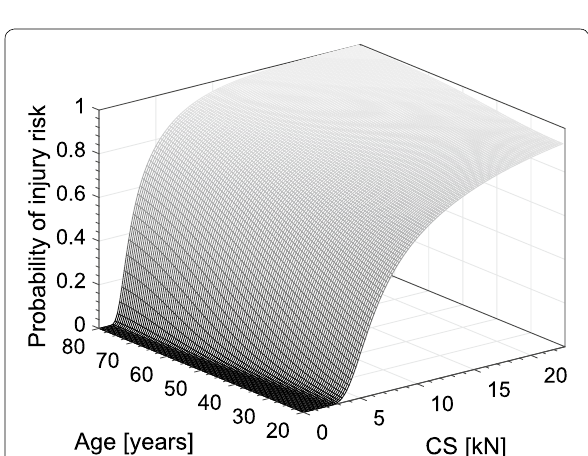
Fig. 9 Low‑risk‑level weighted risk curve for specific ages, R 2 = 0.9955 . CS, compressive strength